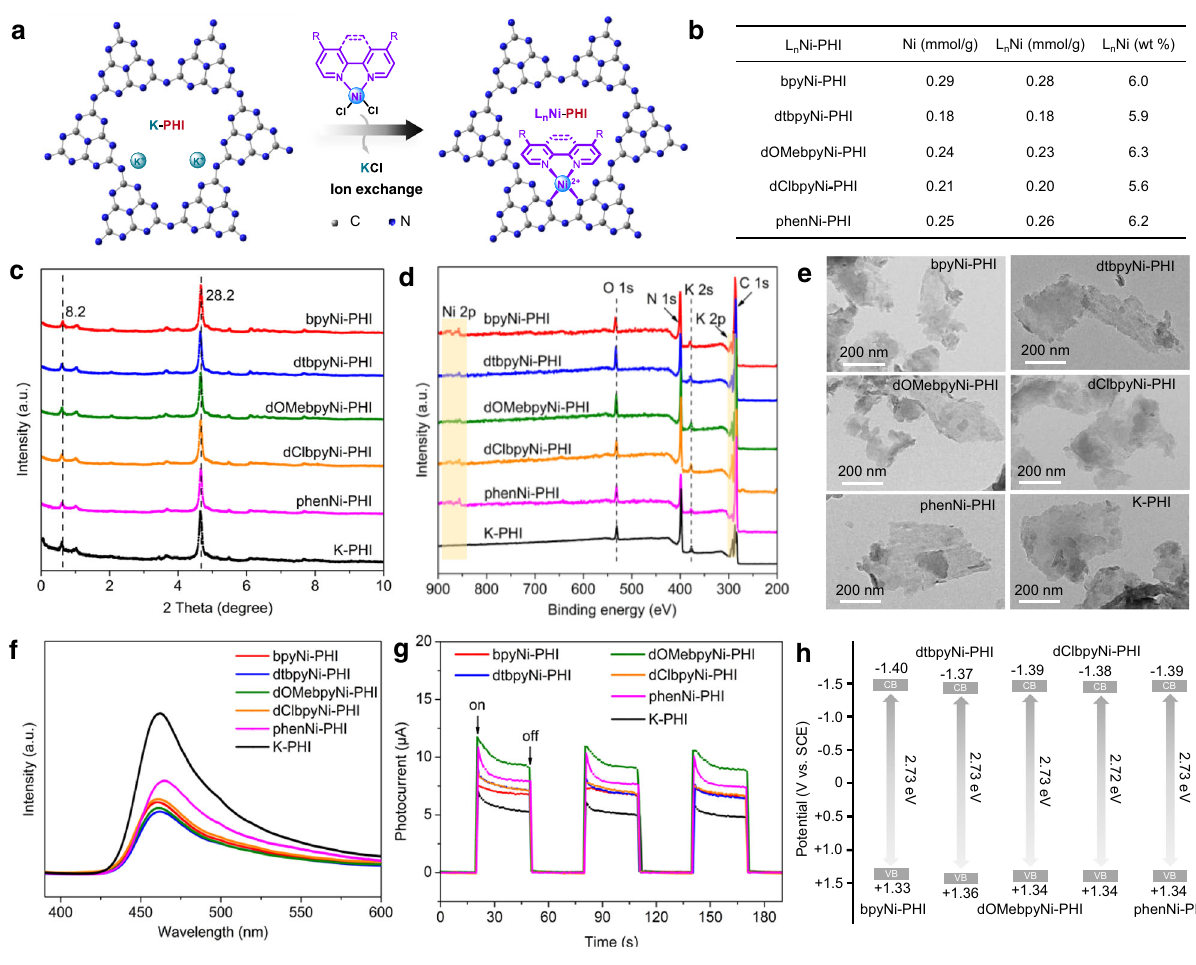
Fig. 2 | Synthesis and characterizations of L n Ni-PHI. a Schematic illustration for the synthesis ofL n Ni-PHIcatalystsbycation exchangemethod. b Amountofnickel andligandinL n Ni-PHIdeterminedbyICP-OESand 1 H-NMRanalysis. c